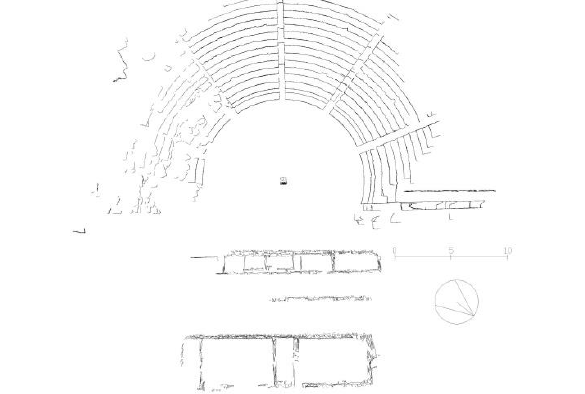
Figure 11 - The theater of Morgantina before the restoration